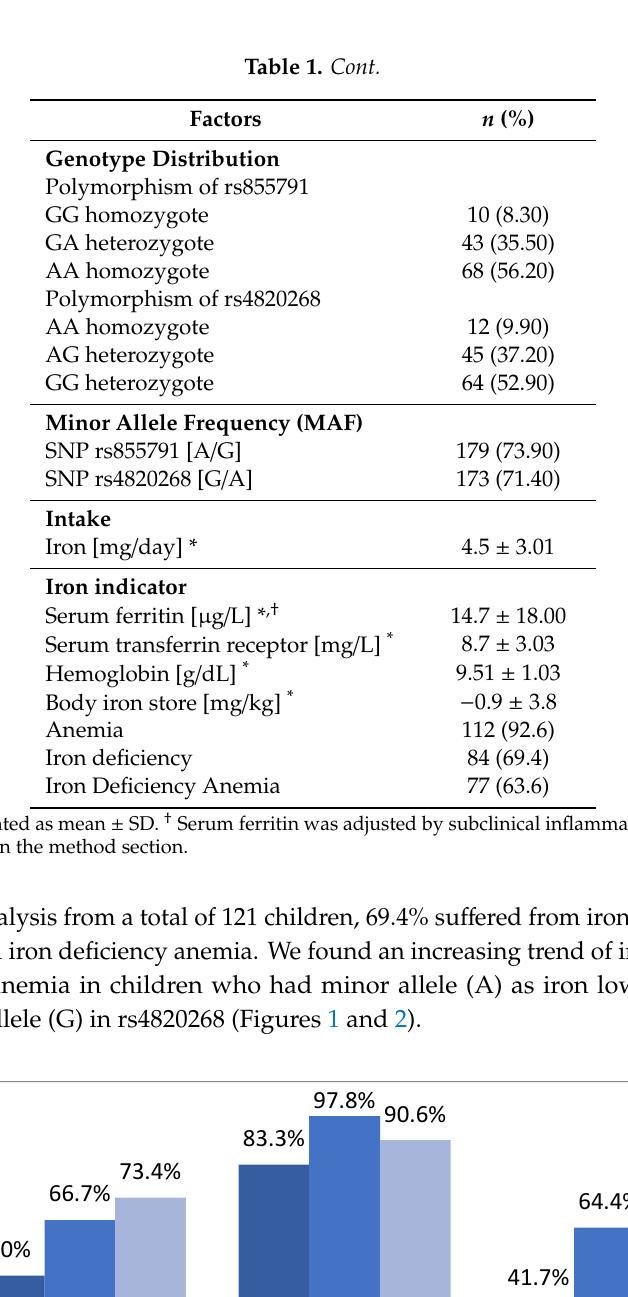
Figure 2. Distribution of Iron deficiency, anemia and iron deficiency anemia status across genotypes of SNPs rs855791